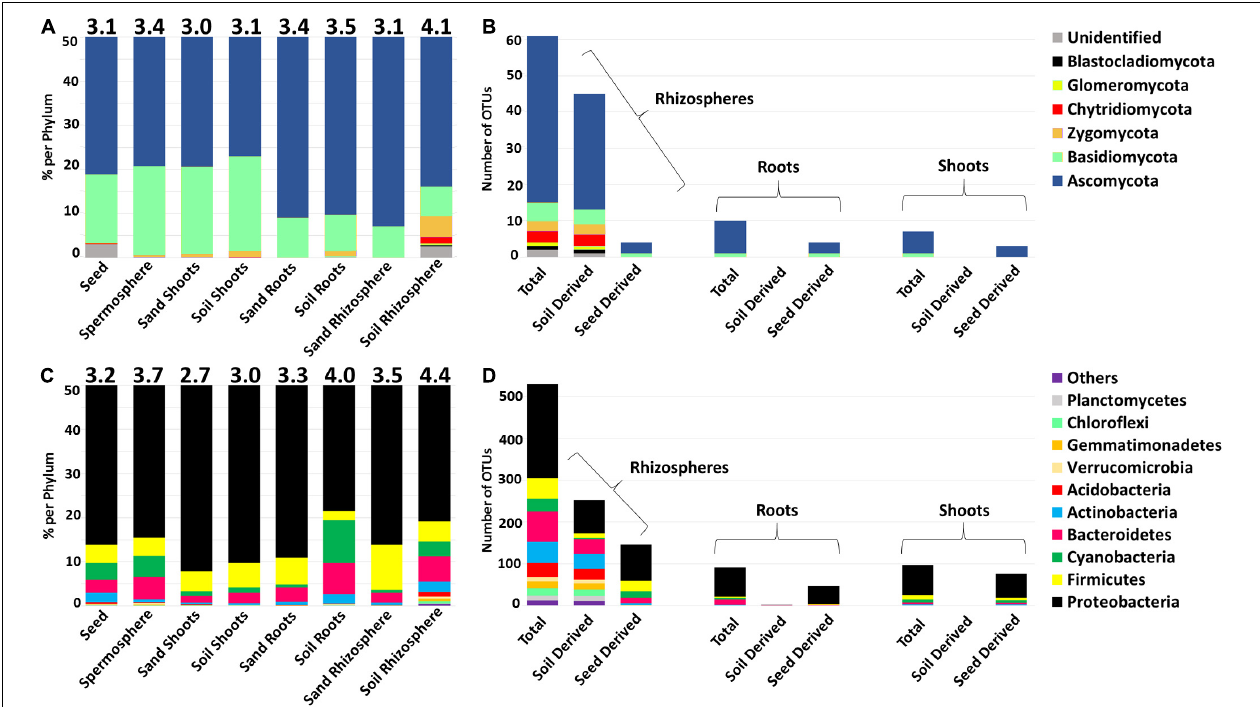
FIGURE 7 | Alpha diversity and phylum-level classification of total (A,C) and common (B,D) OTUs of fungal ITS DNA and bacterial 16S rDNA amplified from seeds, spermospheres, rhizospheres, roots, and shoots. Alpha diversity was measured using Shannon H index and is reported on top of each bar. The proportion of each sample type was calculated by averaging all the samples in each respective group (e.g., average of relative proportions from all seed OTUs). (B,D) Total common OTUs were those that were observed in more than 60% of the shoots/roots/rhizospheres of soil-grown plants, while common soil OTUs were observed in more than 60% of soil-grown samples but not in sterile sand-grown samples. Common seed OTUs were those that were observed in both > 60% of soil-grown tissues and in > 60% of sterile sand-grown tissues. OTUs are classified at the phylum level and shaded according to the legends at the